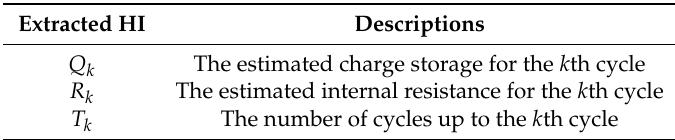
Table 2. Three extracted health indicators (HIs) for SOH